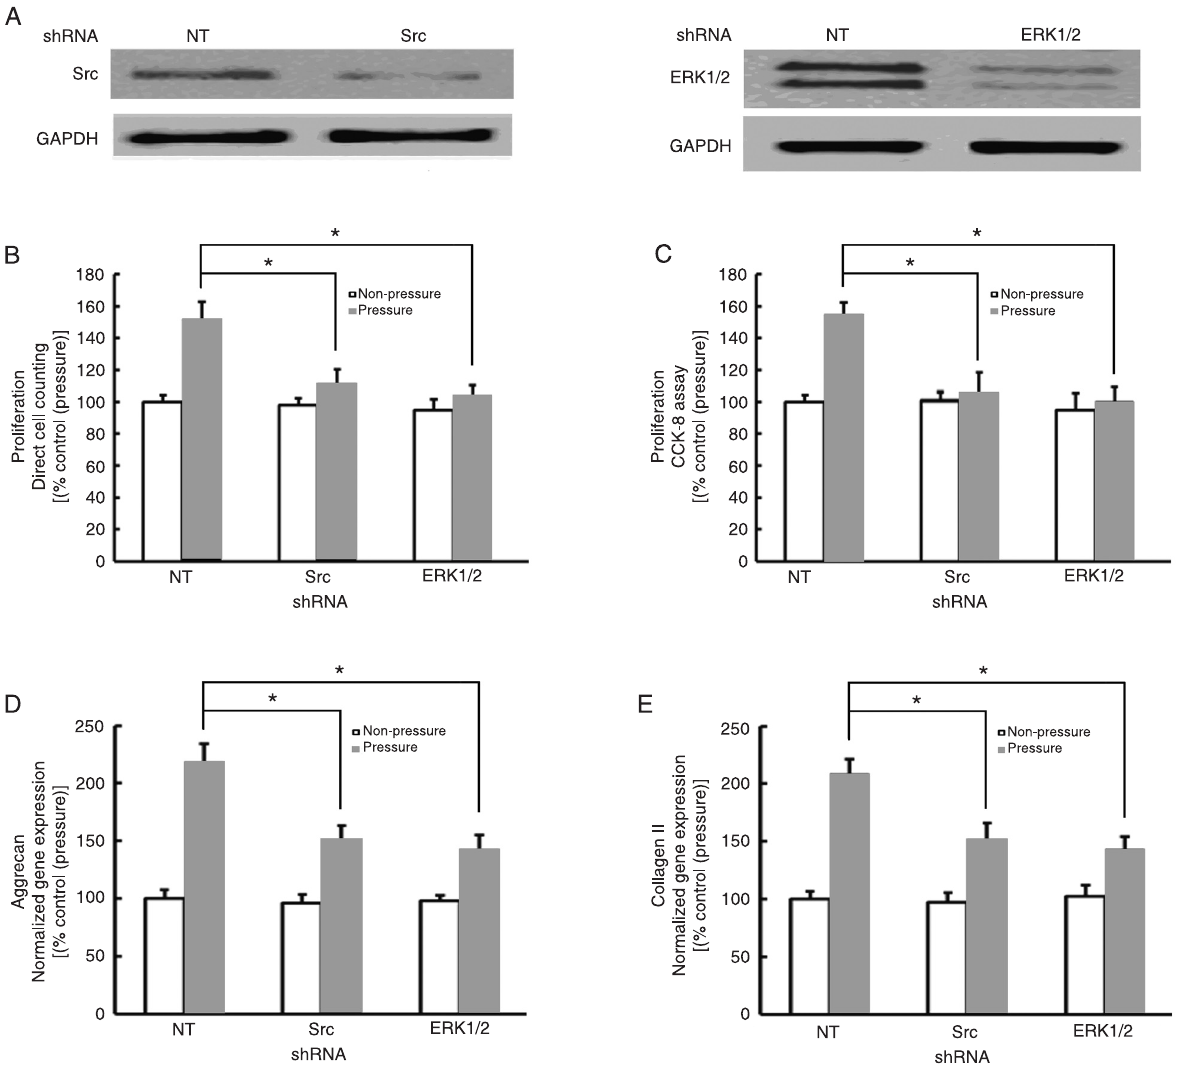
Figure 4. Src shRNA and ERK1/2 shRNA inhibit periodic mechanical stress-induced chondrocyte proliferation and matrix synthesis. A , Chondrocytes were transfected with shRNA targeted to Src or ERK1/2 or with non-targeting (NT) sequences prior to lysis and Western blot for Src and ERK1/2 protein. Either the Src or ERK1/2 shRNA sequence achieved about a 50% reduction in Src or ERK1/2 protein levels. After pretreatment with control shRNA or Src shRNA and ERK1/2 shRNA, rat chondrocytes were cultured for 3 days under static conditions or conditions of periodic mechanical stress 8 h per day prior to proliferation studies. Cell proliferation was analyzed by direct cell counting ( B ) and CCK-8 assay ( C ). Rat chondrocytes were cultured in vitro for 8 h with static conditions or periodic mechanical stress. Aggrecan ( D ) and type II collagen ( E ) gene expression were measured by quantitative real-time PCR. Cell proliferation and matrix synthesis in the inhibitor pretreatment groups was significantly decreased relative to control in chondrocytes in response to periodic mechanical stress (N = 5, *P < 0.05, Student unpaired t